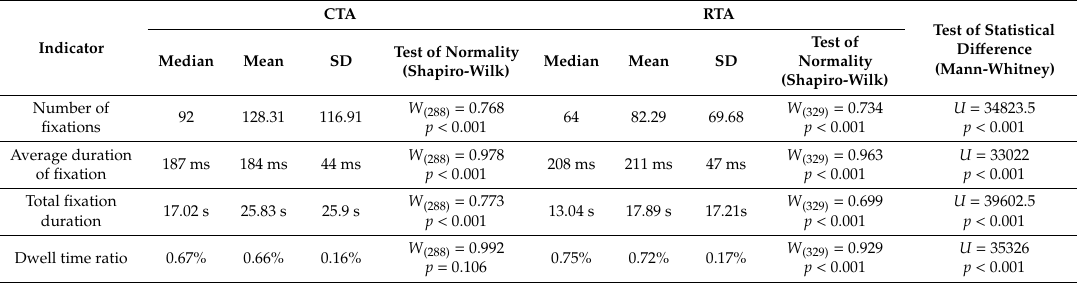
Table 4. Overall comparison of eye-tracking